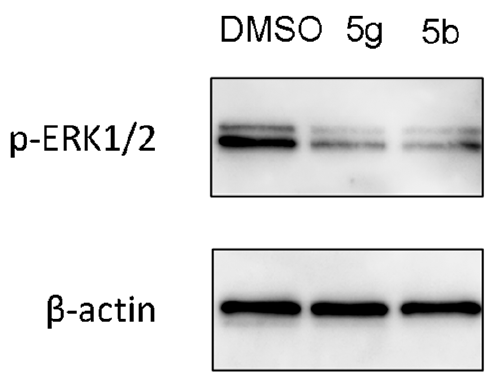
Figure 5. Effect of compounds 5b and 5g on the immunoblotting of p-ERK1/2 proteins.